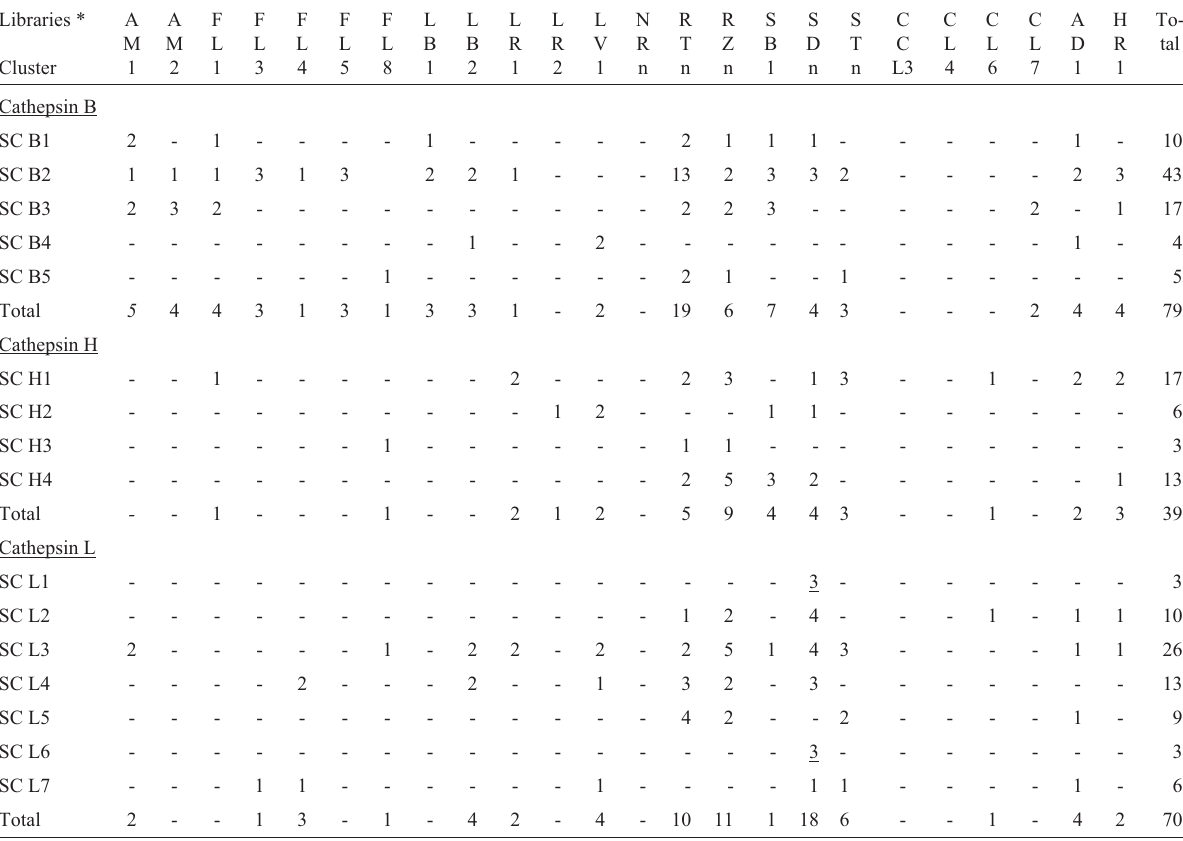
Table IV - Frequency of sugarcane cathepsins B, L and H related reads and clusters on sugarcane cDNA